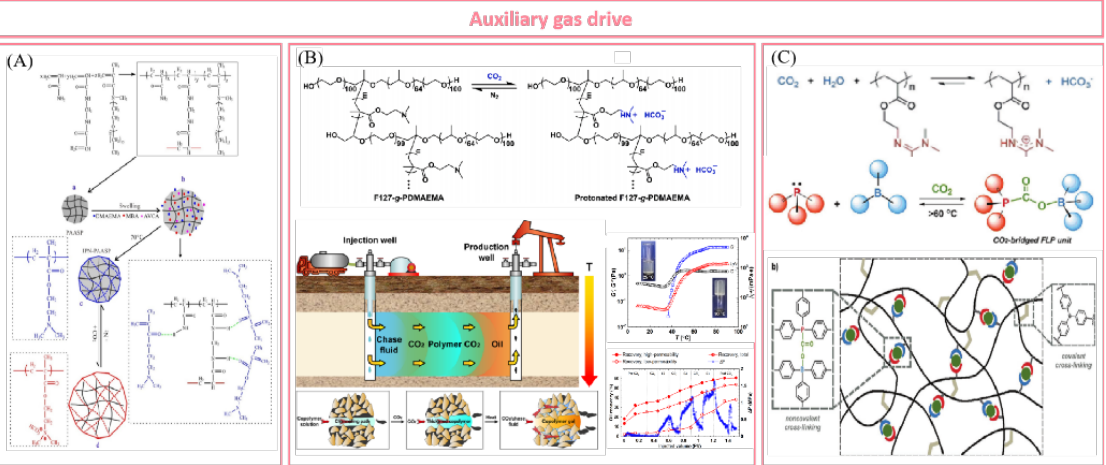
Figure 10. Display of the application of the supramolecular polymers in auxiliary gas drive. ( A ) CO 2 - responsive interpenetrating network based on covalent polymer and supramolecular polymer [155]. ( B ) CO 2 -responsive polymer assisted WAG flooding [156]. ( C ) The bridged FLP unit can be consid- ered as an attractive supramolecular synthon for the creation of supramolecular functional materials [157].